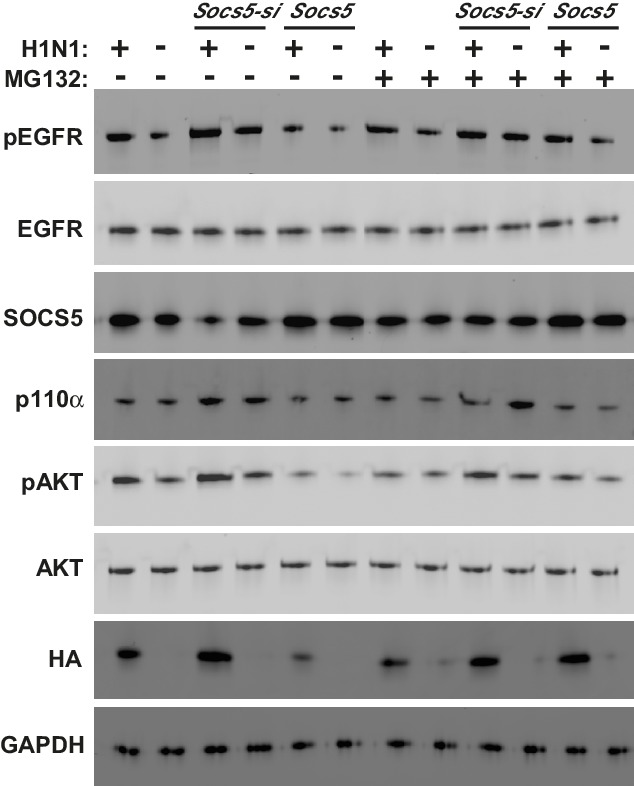
PI3K p110α is not targeted by SOCS5 for proteasomal degradation.The minimally immortalised bronchial epithelial cell line (BCi-NS1.1) was cultured in BEBM complete media (Lonza) and transfected with control siRNA or siRNA to deplete Socs5, prior to addition of the proteasomal inhibitor MG132 (10 μM; 4 h). Cells were then infected with influenza virus H1N1 (MOI 5) and lysed 2 h post-infection. Immunoblot analysis with the indicated antibodies.